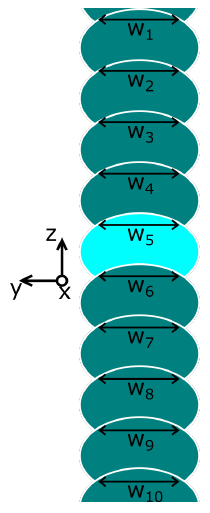
Figure 4. A schematic illustration of the determination of the weld lengths around the layer of interest (layer 10 or 40), which is highlighted. Each ellipsoid thus represents a cross-section of a layer perpendicular to the layer